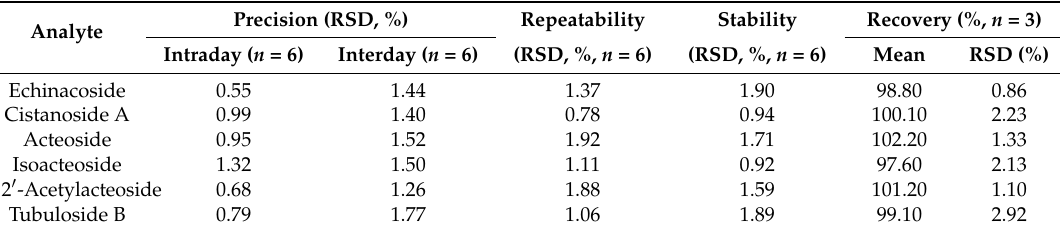
Table 3. Validation of method for identifying six PhGs by